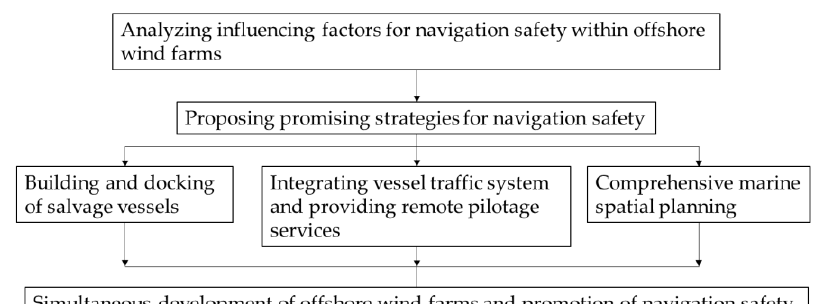
Figure 10. Framework of the proposed strategies for promoting navigation safety.